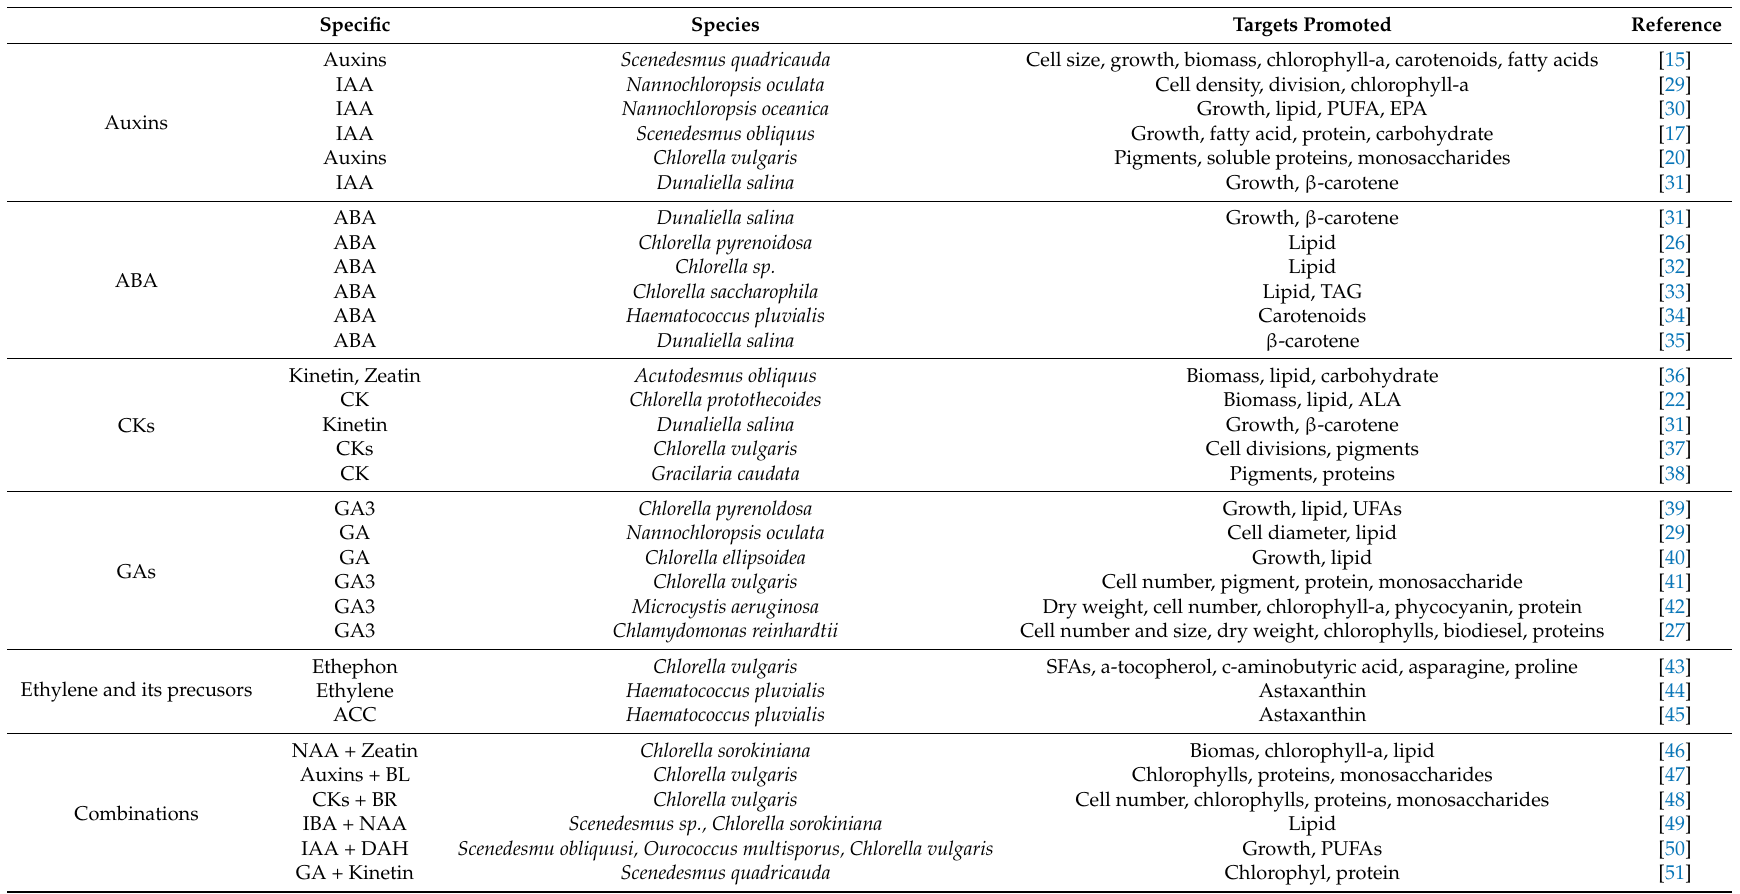
Table 1. Typical cases of effects of phytohormones on